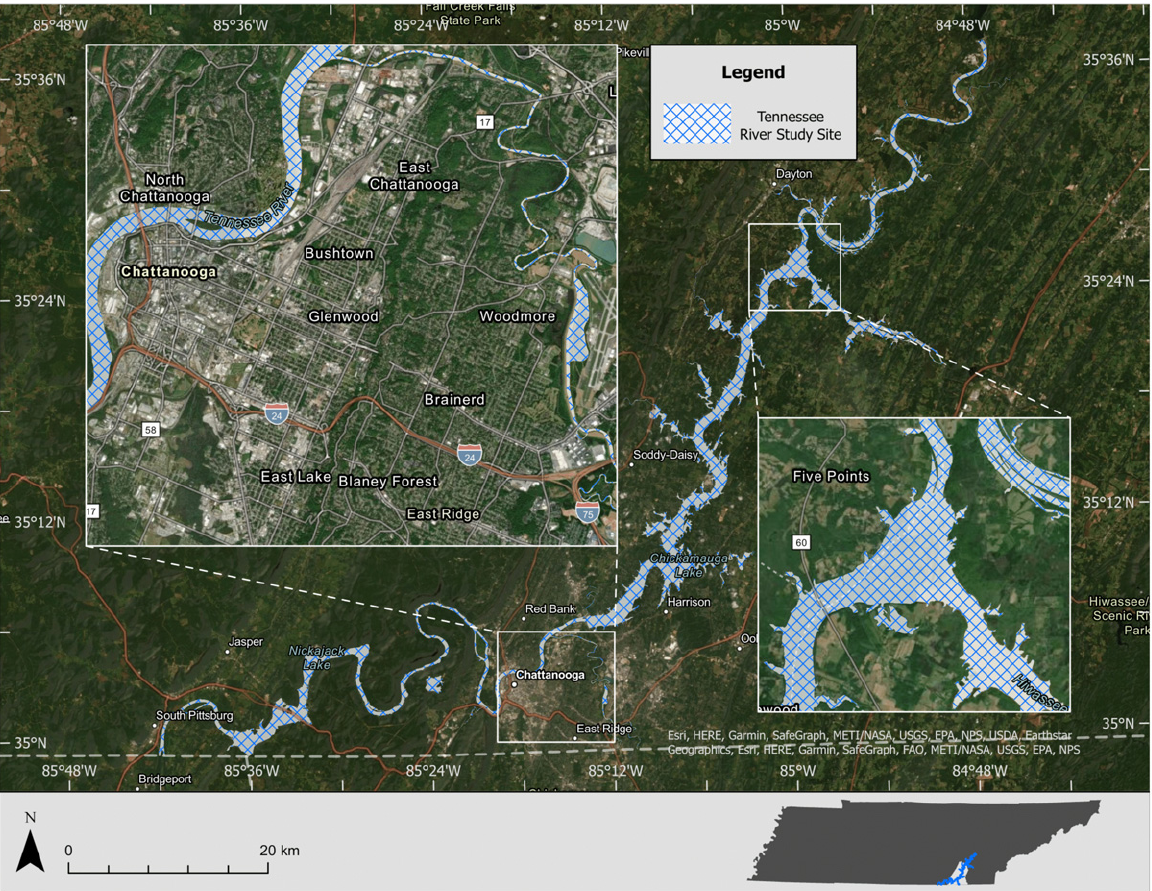
Figure 2. Map showing the location and extent of the study site, the Tennessee River and its surrounding